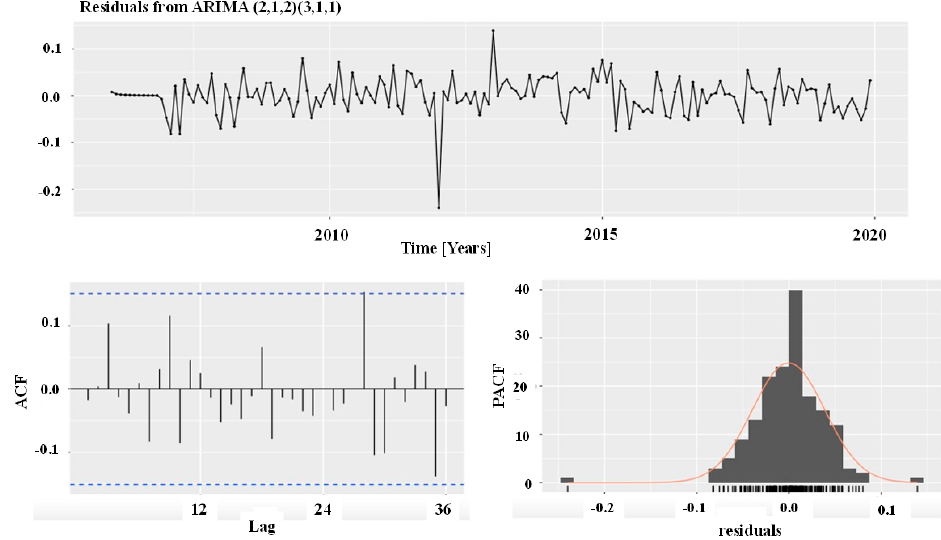
Figure 9. ACF and PACF plots of seasonal and non-seasonal differenced demand. To validate the model, the ACF and PACF of the residual portmanteau test and the distribution of errors were checked using the Ljung-Box. The spikes should be within the significant limits, so they appear as white noise (as shown in Figure 10). The chosen SARIMA model rejected a null hypothesis on the independent distribution of errors. The residuals ACF and PACF of the selected SAMIRA model are within the 95% confidence intervals. The p -value was greater than 0.05 ( p -value = 0.66). Other statistical methods were calculated, such as the mean absolute percentage error (MAPE) obtaining a value of 2.75% with an R 2 at 0.95, confirming the high accuracy of the predicted model.